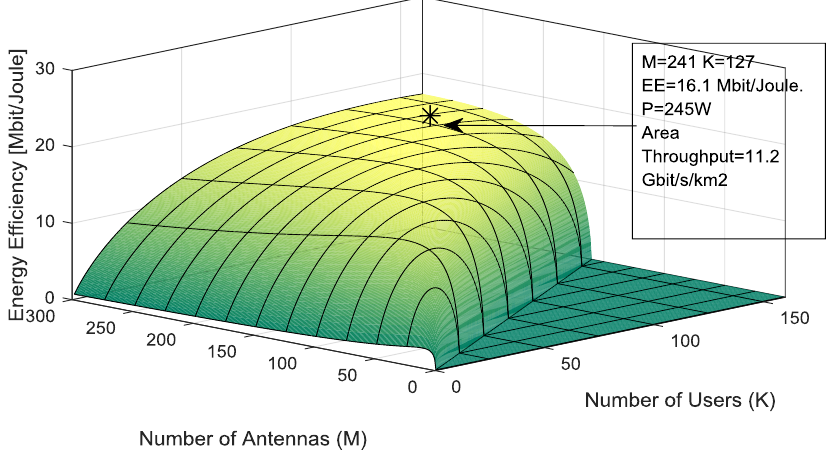
Figure 11. 3-D representation of EE along with optimal parameters under perfect channel situation.